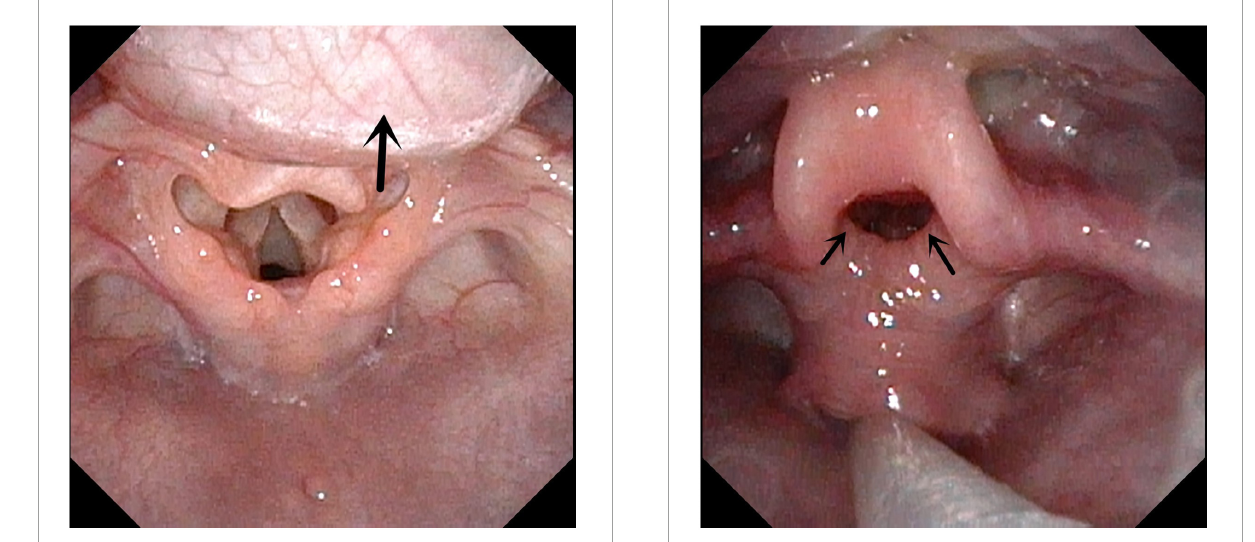
FIGURE1 Tongue base cysts. Arrow indicates the Tongue base cysts.